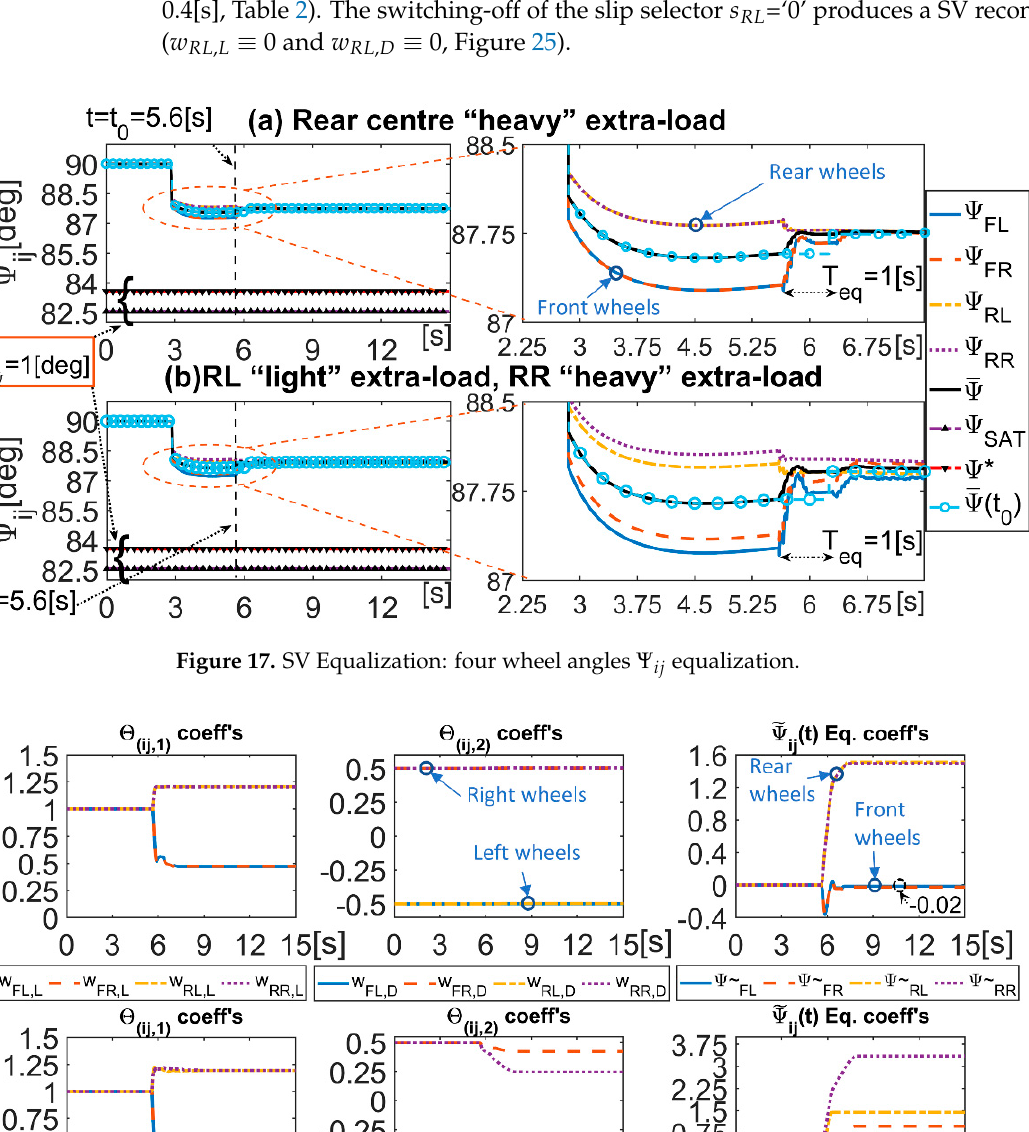
Figure 18. SV Equalization: Pseudoinverse matrix Θ ((cid:3036)(cid:3037),(cid:2869)(cid:2879)(cid:2870)) (32), Ψ(cid:3561) (cid:3036)(cid:3037) (33) equalization coefficients: ( a ) Centre “heavy” extra- load (first-row); ( b ) RL “light”, RR “heavy” extra-load (second-row).